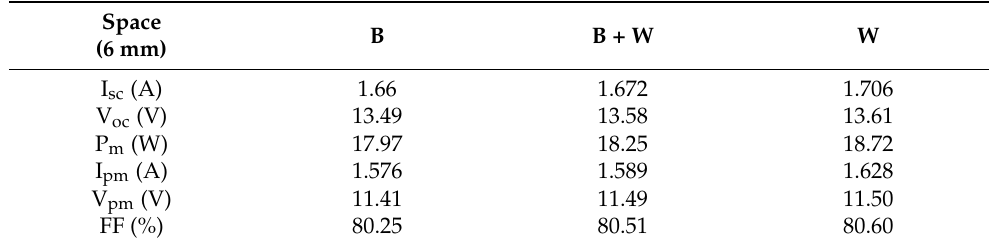
Table A5. The summary of shingled module operating test with various backsheets with 6 mm gap